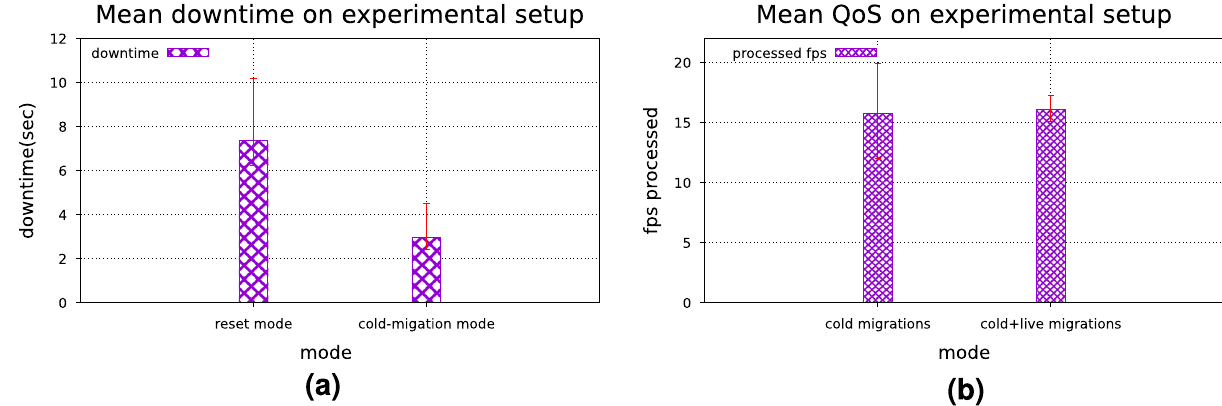
Figure 11. ( a ) Mean downtime with and without cold migrations and ( b ) observed QoS with and without live